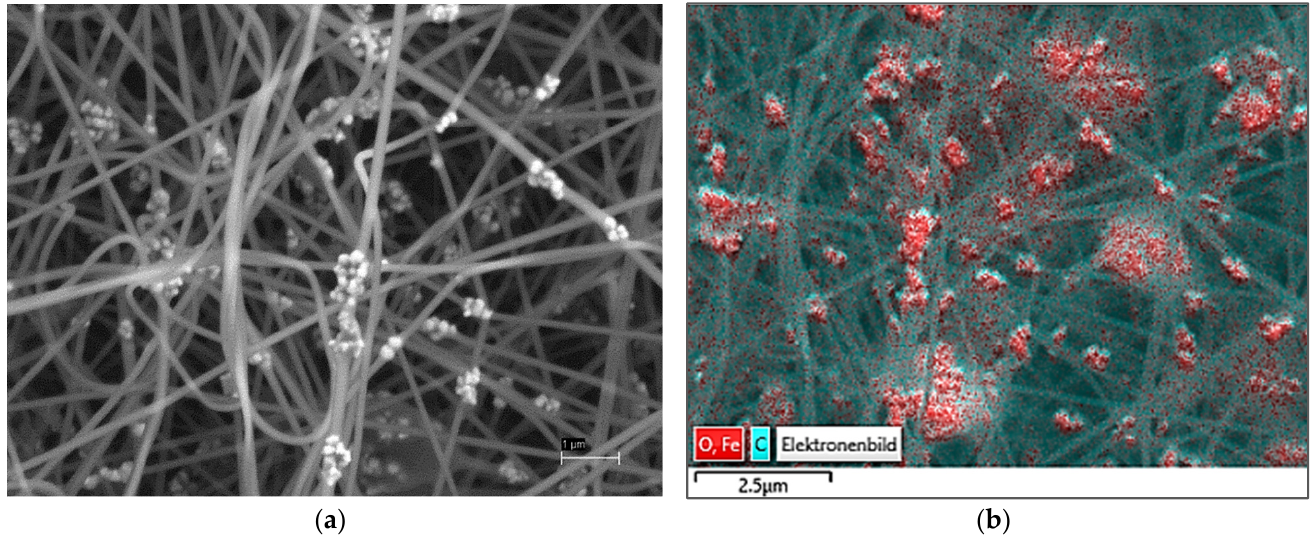
Figure 7. Scanning Electron Microscope (SEM) image of PAN/magnetite nanofiber mat ( a ) and Energy Dispersive X-Ray Spectroscopy (EDS) spectrum showing magnetite in red color ( b ). The scale bars indicate 1 μ m ( a ) and 2.5 μ m ( b ).